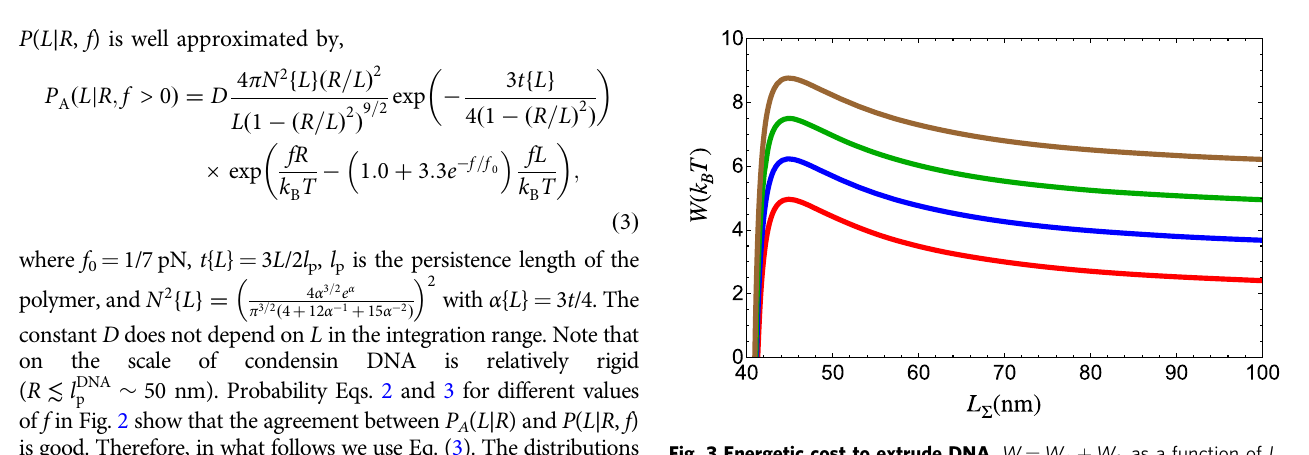
Fig. 3 Energetic cost to extrude DNA. W = W 0 + W f , as a function of L Σ (~total extruded length of DNA; L Σ = L 0 + L 1 ) for different f values on DNA. We set R 1 = 40 nm as the size of condensin in open state (State 1 in Fig. 1) and R 2 = 14 nm, which corresponds to Δ R = 26 nm as obtained from the fi t of our theory to experiment 9 in later section. f = 0 pN is in red, f = 0.2 pN is in blue, f = 0.4 pN is in green, and f = 0.6 pN is in brown. We used the persistence length of DNA, l DNA ¼ 50 p